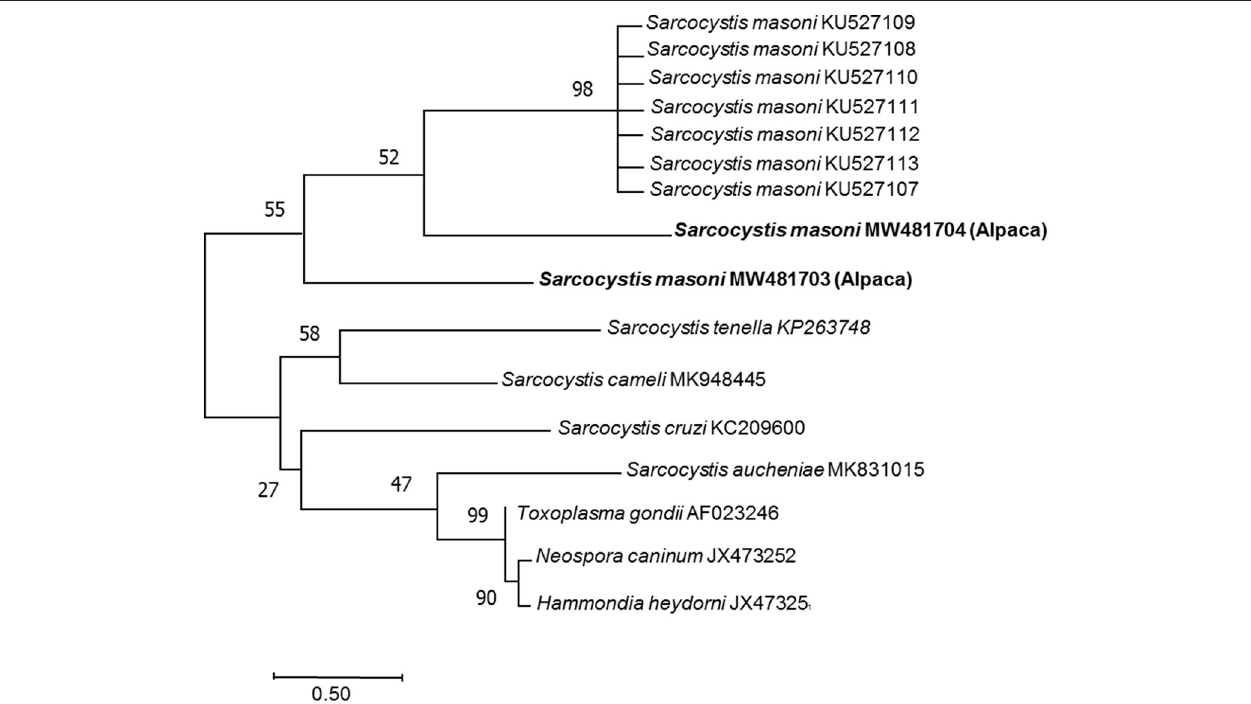
FIGURE 2 | Phylogenetic tree among the Sarcocystis masoni from the alpaca identified in this study and other Sarcocystis spp. The phylogeny was inferred from the neighbor-joining analysis of the 18S rRNA sequences based on the distances calculated using the Kimura two-parameter model. Bootstrap values N > 50% from 1,000 replicates are shown at the nodes. Sarcocystis spp. (MW481703, MW481704) close relationship to Sarcocystis masoni (KU527107, KU527108, KU527109, KU527110, KU527111, KU527112, and KU527113). for Sarcocystis spp. from alpaca were S. masoni (100%